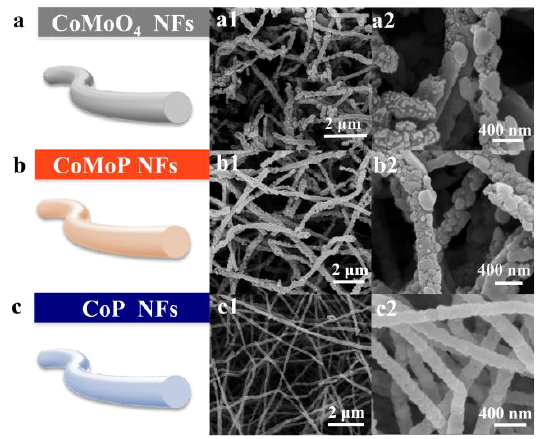
Figure 1. ( a – c ) Schematic and SEM images of ( a1 – a2 ) CoMoO 4 NFs, ( b1 – b2 ) CoMoP NFs, and ( c1 – c2 ) CoP NFs.